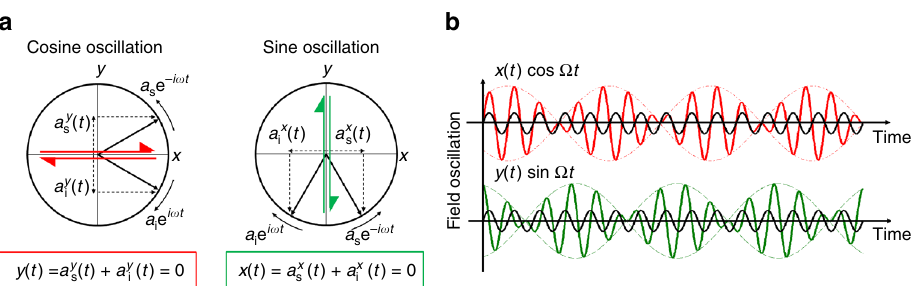
Fig. 5 Time-domain illustration of a pure two-mode quadrature oscillation with a single-frequency component. a Quadrature maps of the signal and idler fi eld amplitudes a a Ω ¼ ω s þ ω i . Due to the frequency difference from the carrier, the amplitudes of the signal s , i in a rotating frame at the carrier frequency 2 and idler rotate around the quadrature map in opposite directions at rates + ω = ω s − Ω and − ω = ω i − Ω . If the two amplitudes are equal in magnitude a j j ¼ a j jð Þ , they constantly cancel out along one quadrature axis, and add up along the orthogonal axis to form an oscillating beat — the pure quadrature s i ð t Þ þ a y ð t Þ ¼ 0, and for the sine oscillation a x ð t Þ þ a x ð t Þ ¼ 0. b Time-domain illustration of pure two-mode oscillation; for the cosine oscillation a y i s s i quadrature oscillations, showing the two-mode beat envelope at frequency ω modulating the carrier frequency oscillation. The quadrature axis is de fi ned by the phase φ s þ φ i of the carrier of the two-mode oscillation relative to a reference LO (black) − 0, π for the x ( ω ) quadrature (cosine) and ± π 2 phase of the quadrature amplitude φ s (cid:2) φ i re fl ects the temporal offset of the beat envelope with respect to a 2